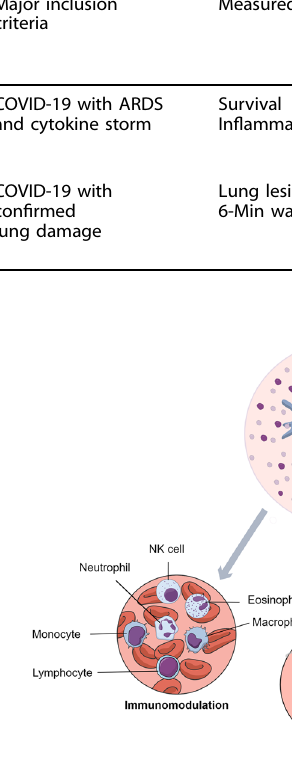
Table 1. Double-blind, randomized, controlled trials using MSCs in COVID-19 patients. Type of MSCs administered